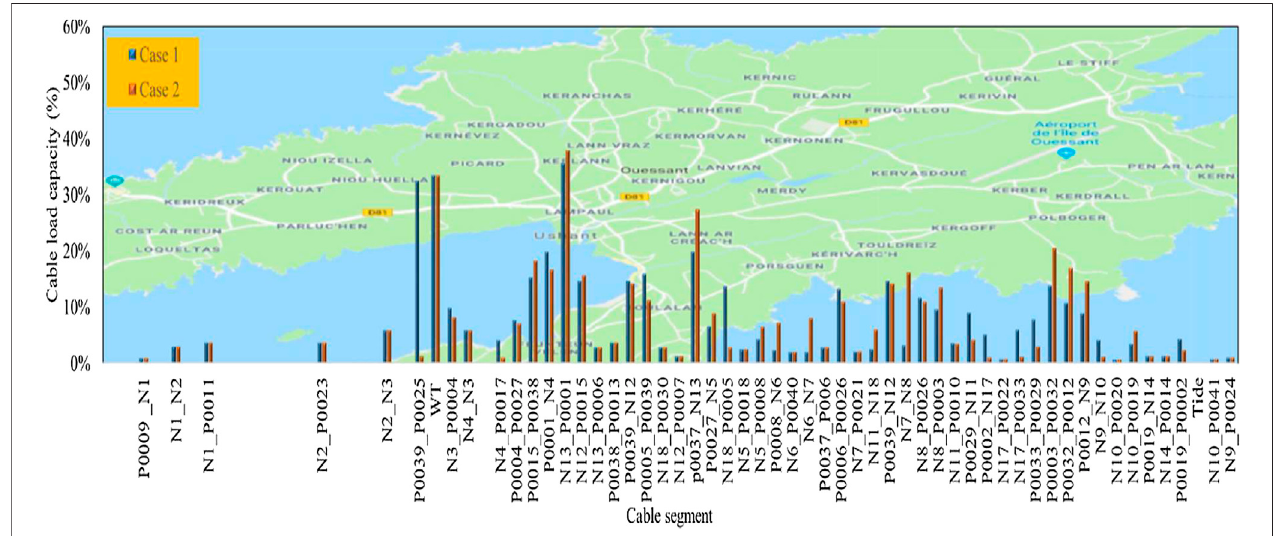
FIGURE 17 | Cable capacity usage under two cases of the WT locations.